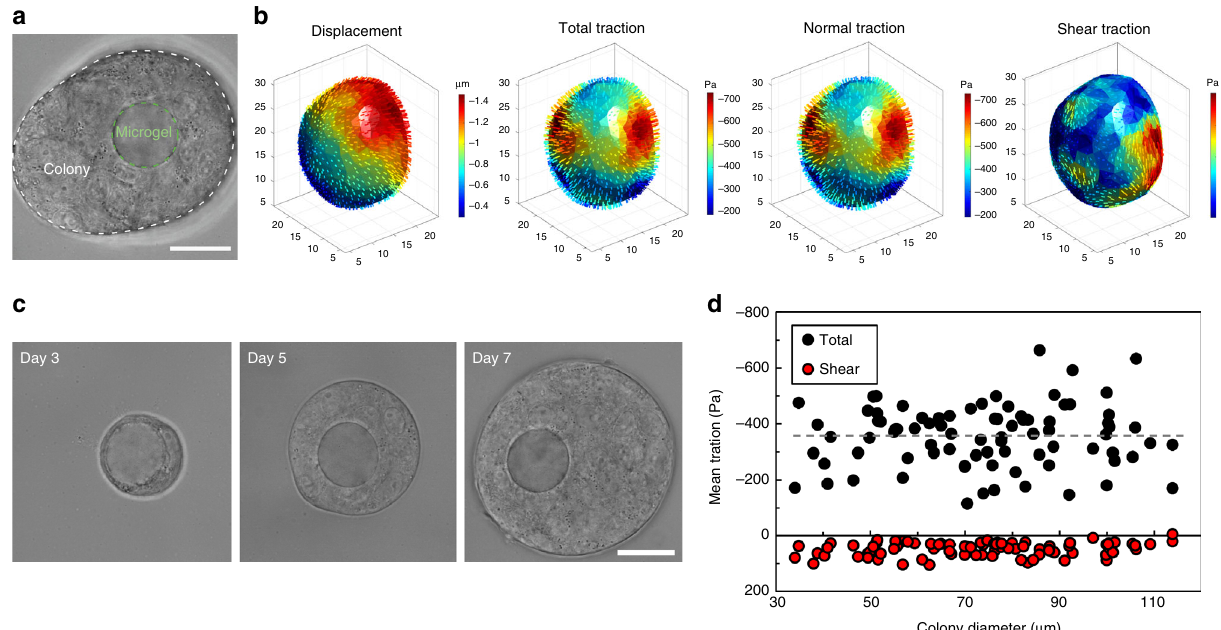
Fig. 7 Tractions on the microgels do not increase with tumor colony sizes. a An example of an encapsulated ERMG (Young ’ s moduli of 1440 Pa) inside a 3D melanoma colony of TRCs (Day 6 of culture). The colony grew from a single melanoma cell at Day 0. Green dashed line, microgel; white dashed line, edges of the colony. b 3D deformation and corresponding tractions of the ERMG. c Representative images of three different melanoma colonies at different days of culture, each colony encapsulating an ERMG. Each colony (of all colonies) grew from a single melanoma cell at Day 0. d Average absolute total and shear traction on the surface of each ERMG as a function of colony size. Solid line, arithmetic mean of total tractions. Average total and shear tractions are − 357.9 ± 12.03 Pa and 49.1 ± 2.58 Pa, respectively (mean ± s.e.m., n = 87 ERMGs). All scale bars, 25 µ